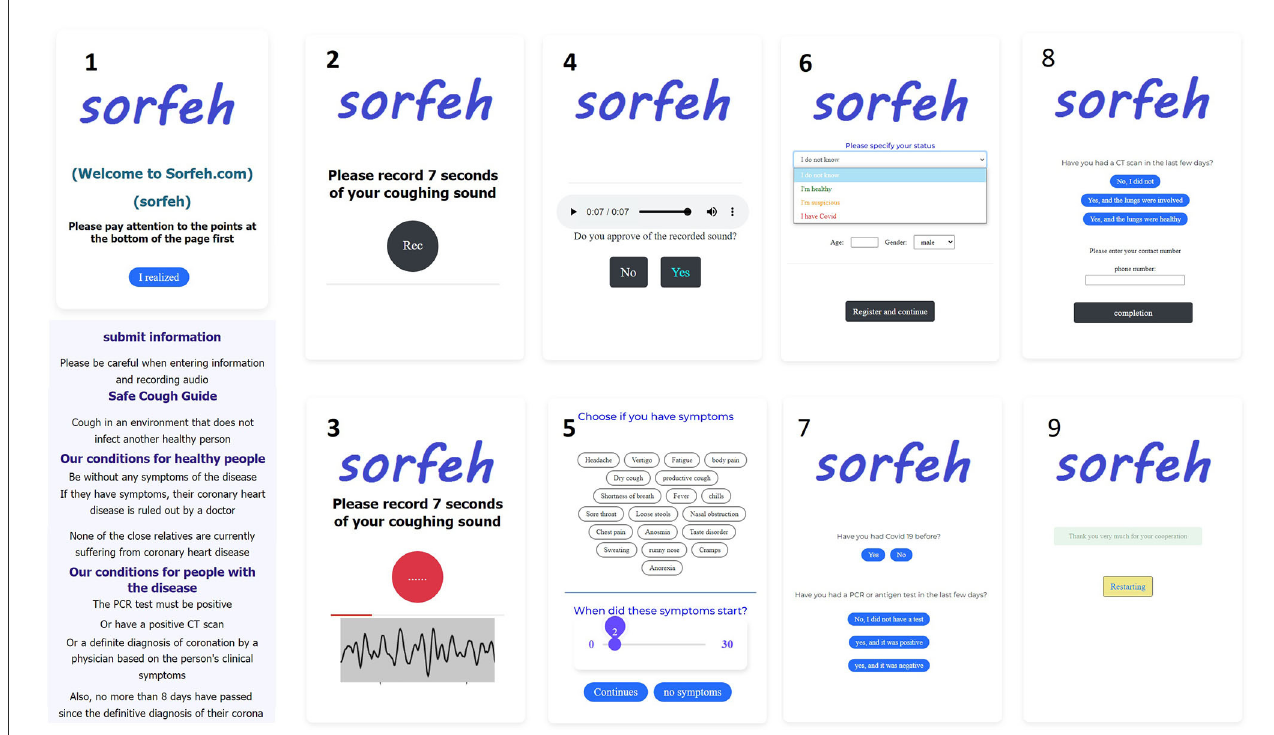
FIGURE1 How to collect data and its steps on the